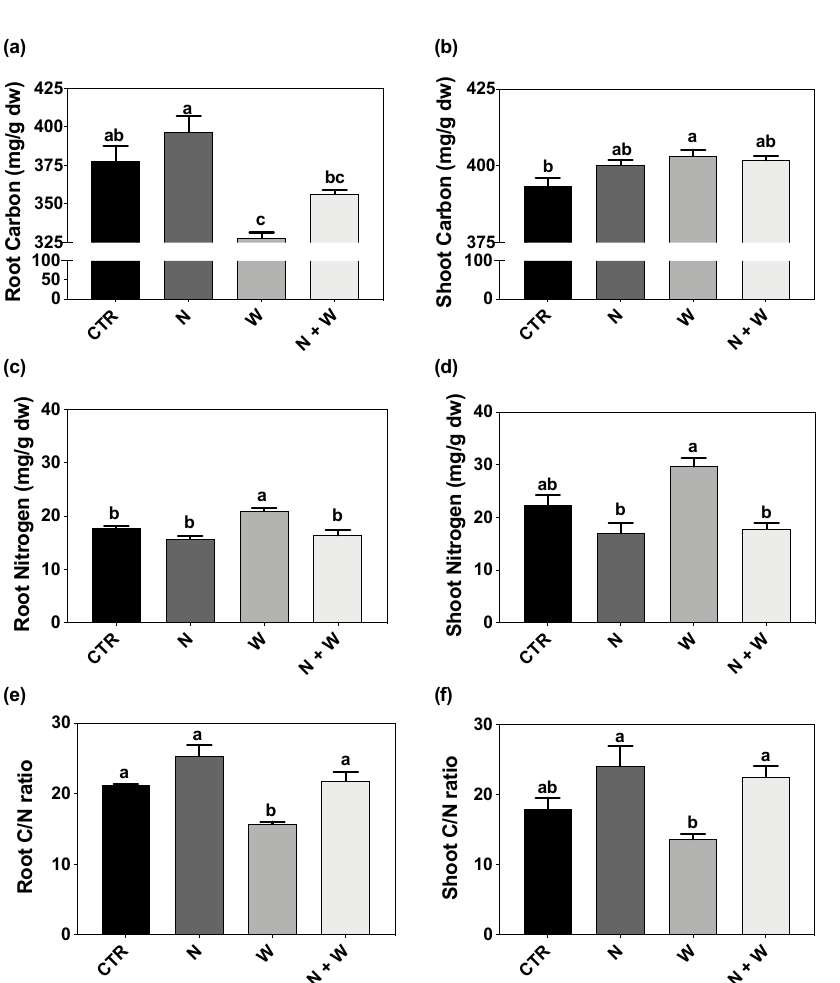
reached the lowest values in the roots and shoots of W-deficit plants, decreasing by 28% and 39%, respectively, when compared to the combined N+W deficit (Figure 4e,f).